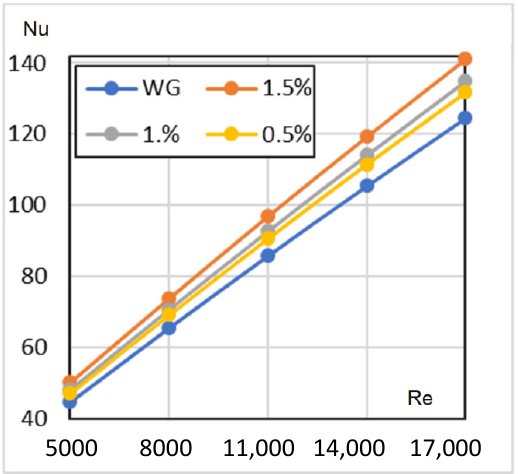
Figure 10. Nusselt numbers against Reynolds numbers for a constant wall temperature.